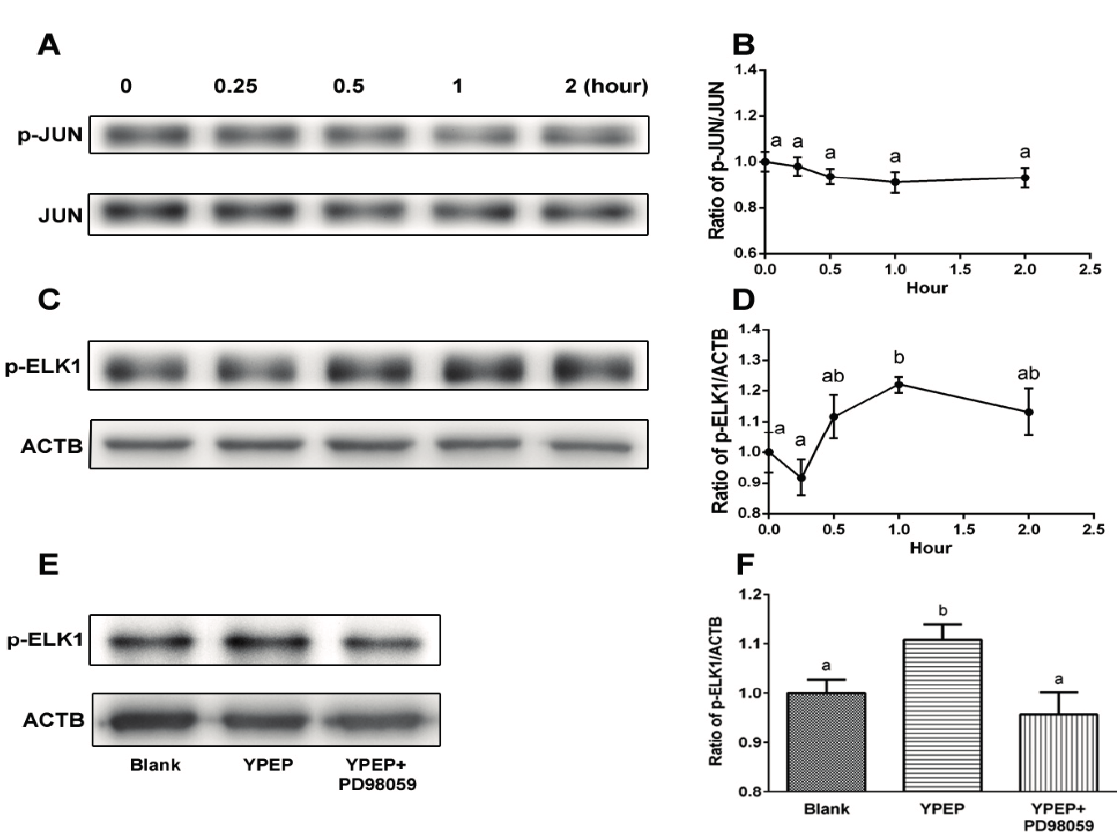
Figure 4. ( A , C ) Effects of YPEP on JUN and ELK1 activation. Western blot analysis of the JUN and ELK1; ( B , D ) Densitometric results of JUN and ELK phosphorylation; ( E ) YPEP-induced ELK phosphorylation was abolished by PD98059 (inhibitor of ERK1/2); ( F ) Densitometric result of ELK phosphorylation. ACTB: gene name of beta actin.